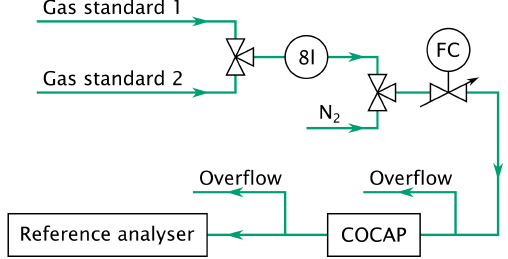
Figure 5. Setup used to determine a calibration curve for the CO 2 sensor. FC is a mass flow controller. The 8L buffer volume was flushed with either of two gas standards differing in CO 2 content, providing a slowly changing CO 2 dry air mole fraction. The second three-way valve is used to deliver nitrogen with zero CO 2 at the beginning and the end of each